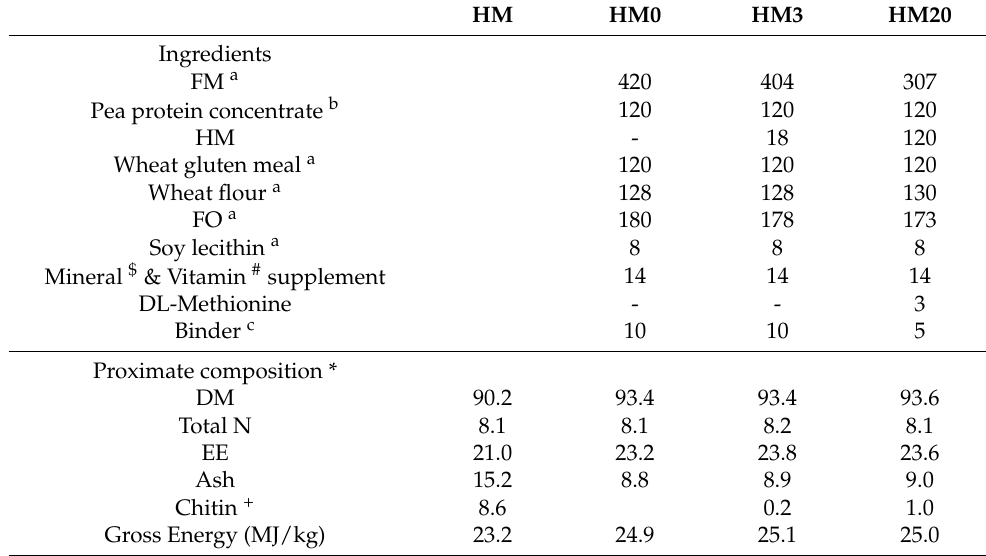
Table 1. Ingredients (g/kg) and proximate composition (% DM) of HM and experimental diets. HM HM0 HM3 HM20 Ingredients FM a 420 404 307 Pea protein concentrate b 120 120 HM - Wheat gluten meal a 120 Wheat flour